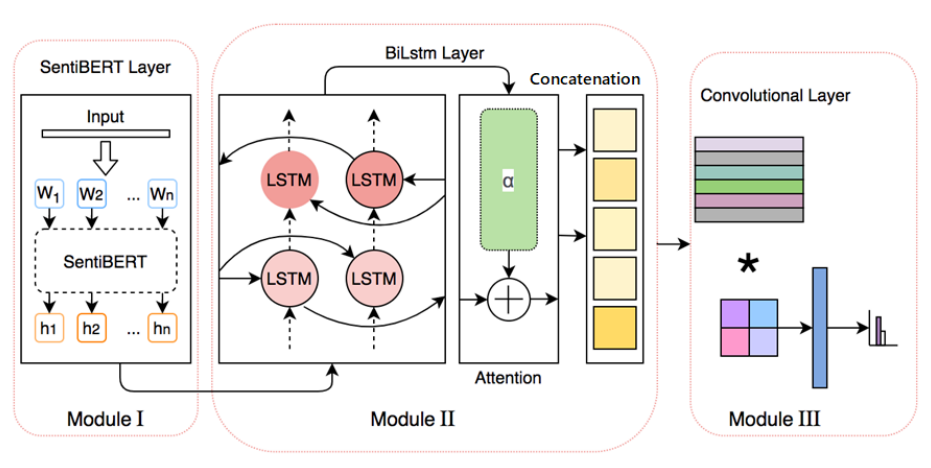
Figure 3. An overview of the SentiBERT-BiLSTM-CNN learning